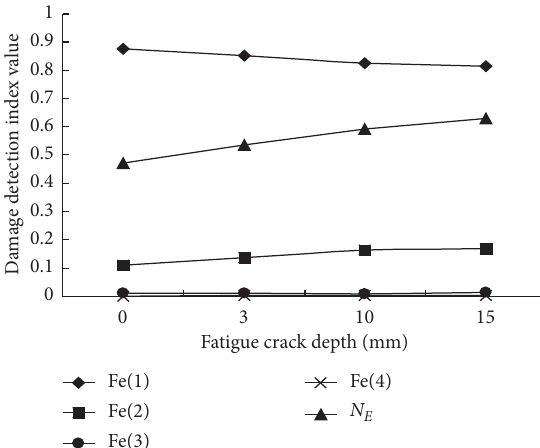
Figure 6: Harmonic excitation damage detection index change curve.